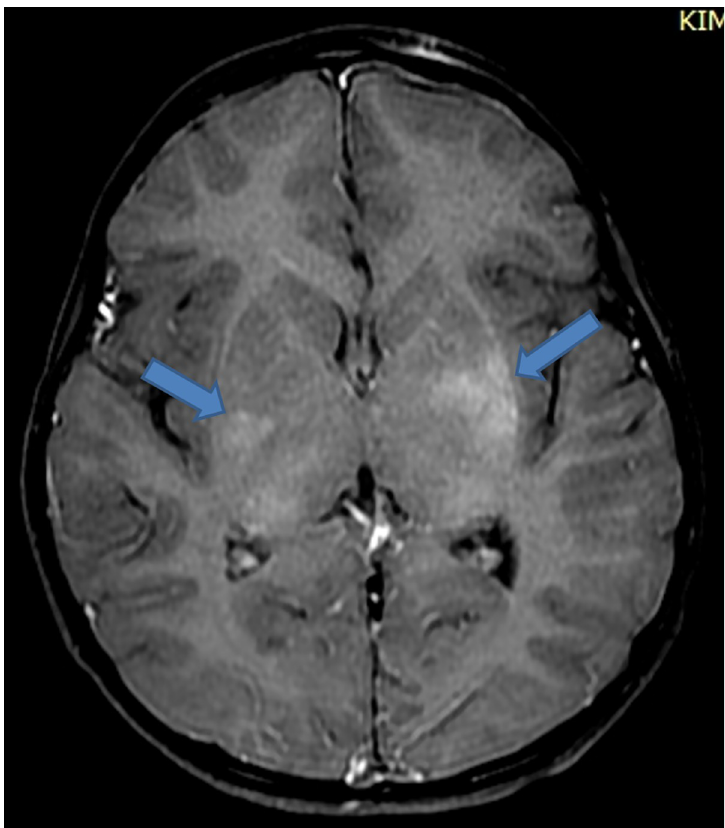
Fig 5. Patchy heterogeneous enhancement seen in bilateral basal ganglia and external capsule on postcontrast study [3].